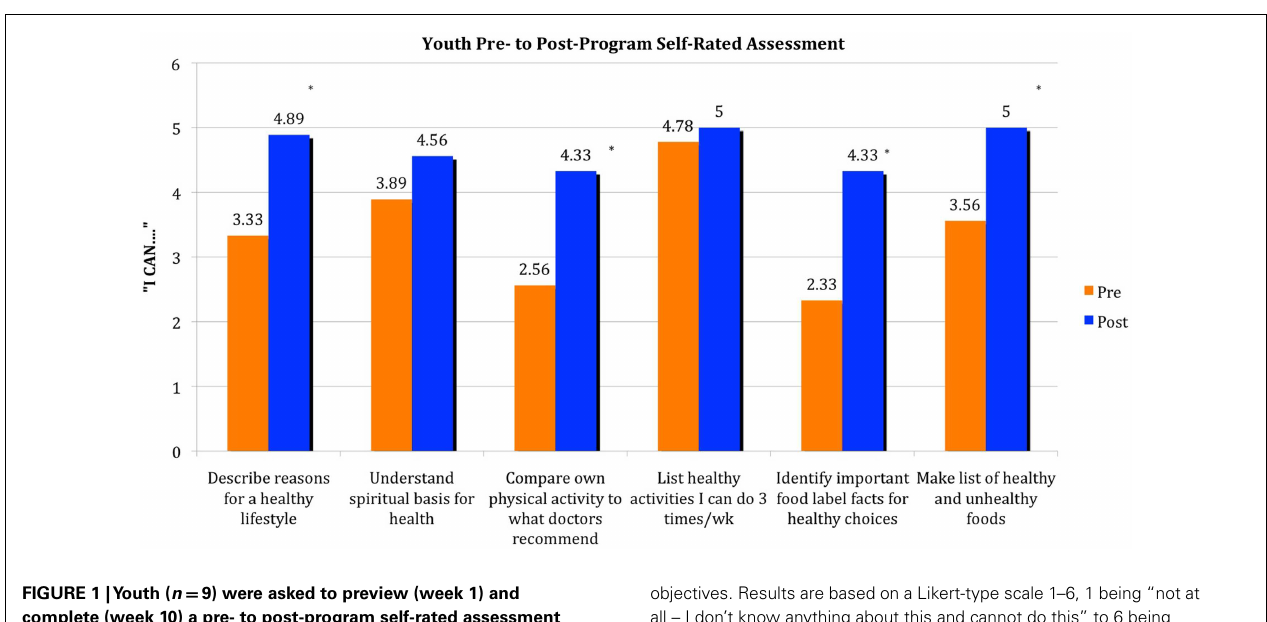
FIGURE 1 |Youth ( n = 9) were asked to preview (week 1) and complete (week 10) a pre- to post-program self-rated assessment of skills associated with physical activity and nutrition . Statements began with “I can ... ” and corresponded with the program’s